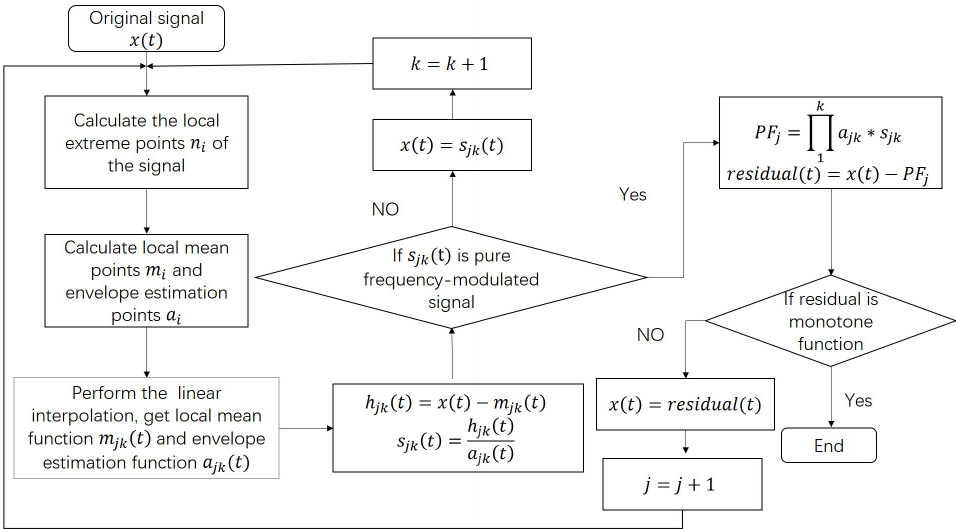
Figure 1. Flow chart of the proposed Interpolated